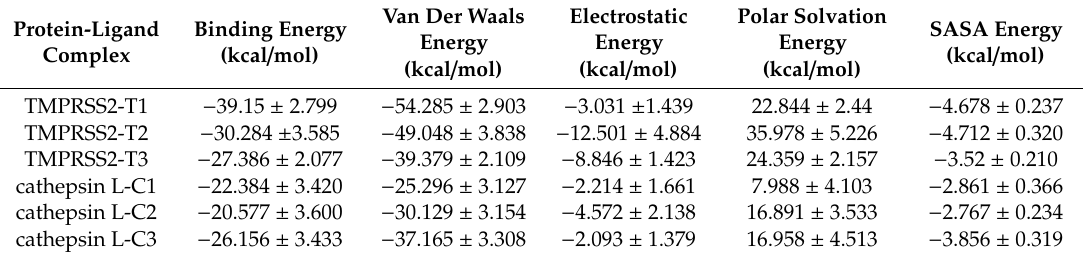
Table 3. MM-PBSA based binding energy for top three inhibitors of TMPRSS2 and cathepsin L.